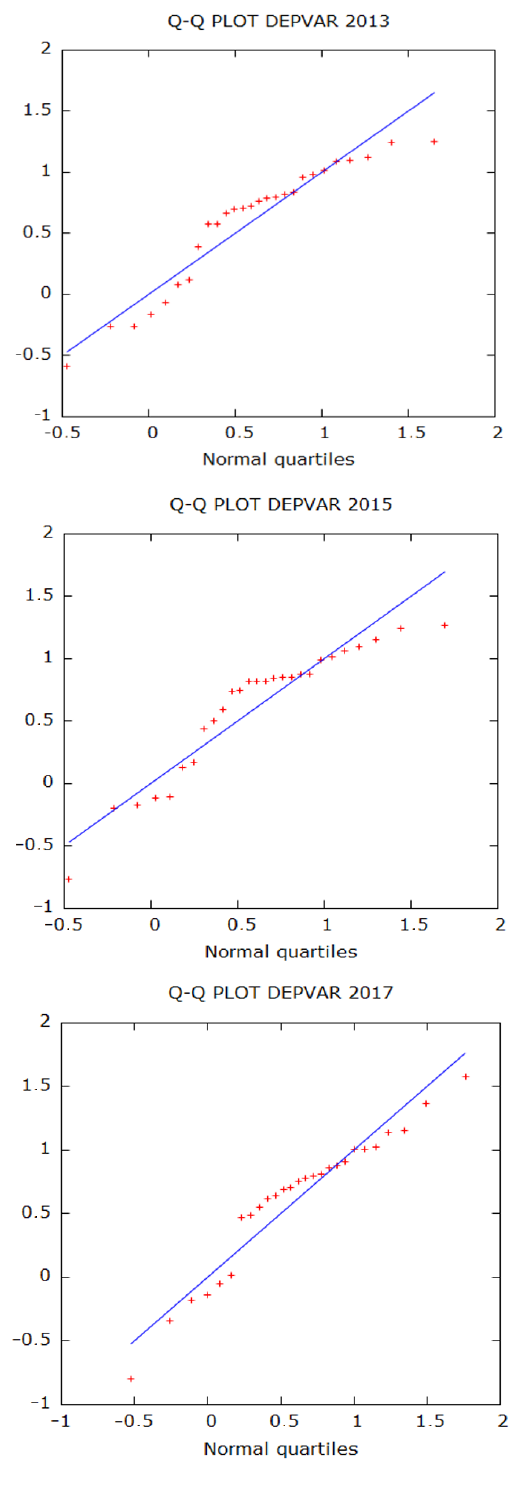
Figure 1. Trend distribution of the production function by annual Normal Plot diagram of the de- pendent variable of the model.